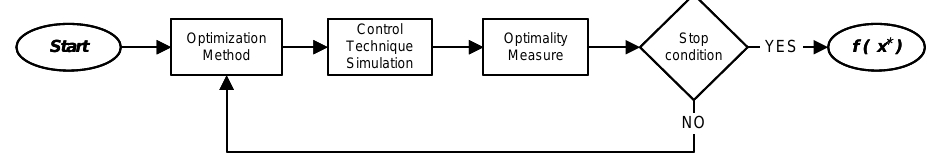
Figure 2. Flowchart of the optimization process applied to